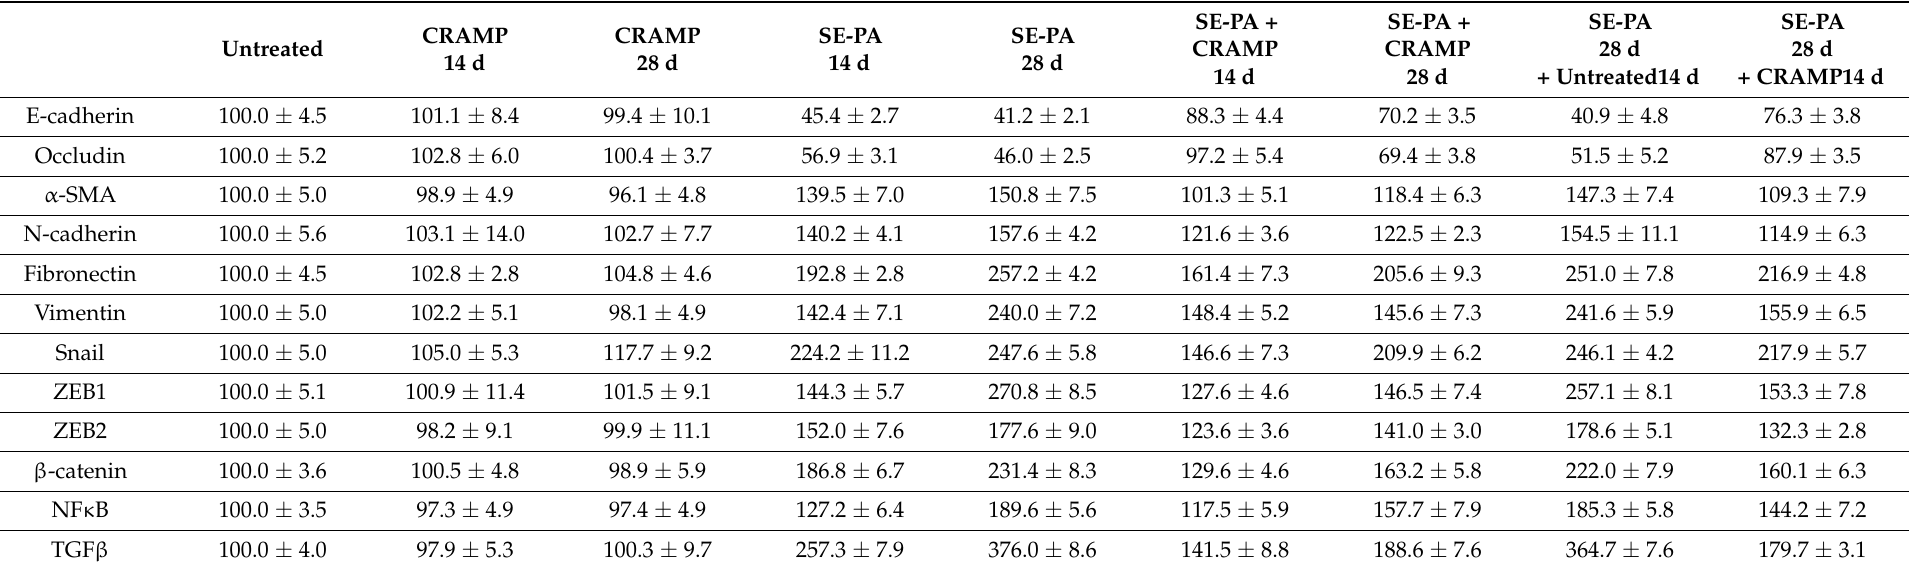
Table 2. Expression of proteins involved in EMT in response to cathelicidin (CRAMP) and/or saline extract of Pantoea agglomerans (SE-PA) treatment. Results are presented as the mean of protein expression ±